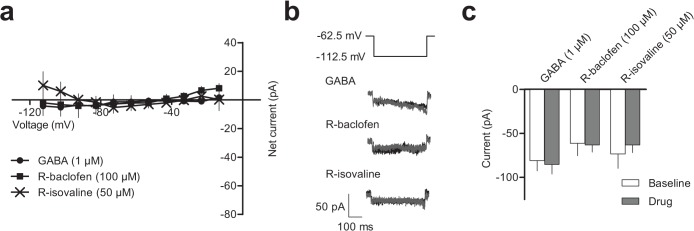
GABA, R-baclofen and R-isovaline do not evoke currents in untransfected AtT-20 cells.
a) Baseline subtracted IV curve for GABA (n = 4), R-baclofen (n = 4) and R-isovaline (n = 5). b) Example currents at the maximum hyperpolarising step (-112.5 mV, voltage step depicted above currents) at baseline (black) and on application (grey) of GABA, R-baclofen or R-isovaline. c) Summary graph showing currents recorded at -112.5 mV at baseline (open bars) and on application of GABA, R-baclofen, or R-isovaline (shaded bars). Data are represented as mean ± SEM.